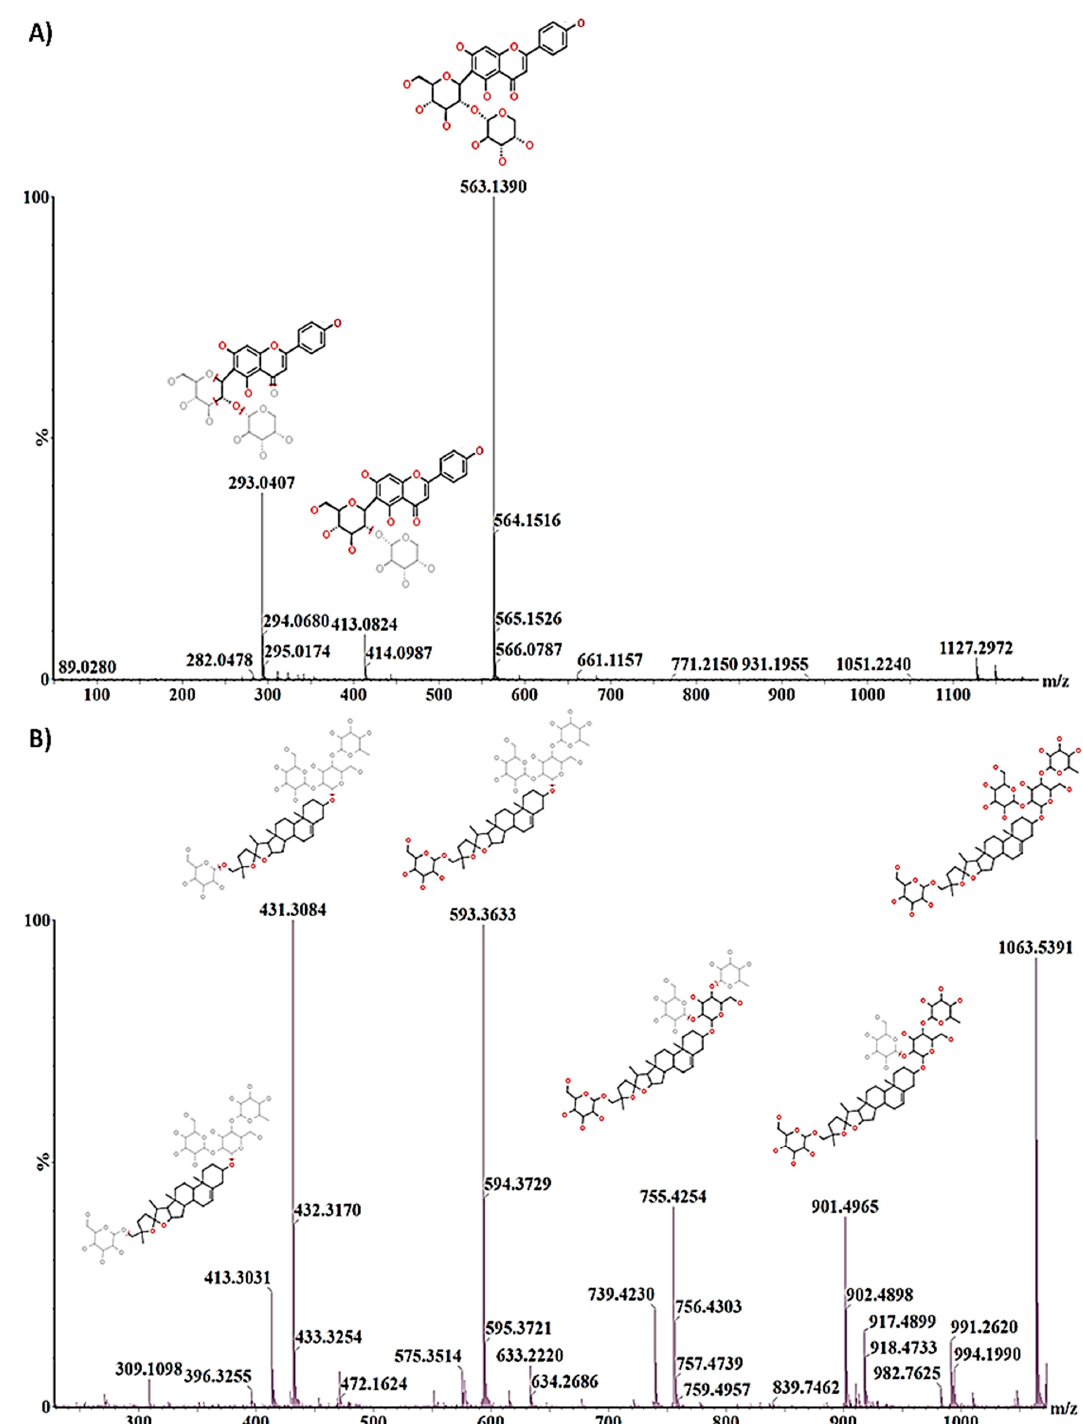
Figure 5. Representation of the use of fragmentation patterns for the annotation of secondary metabolites. ( A ) Isovitexin 2 ″ - O -arabinoside showing the parent ion at m / z 563 and two diagnostic fragment ions at m / z 413 and 293. ( B ) Avenacoside A at an m/z of 1063 showing diagnostic fragments ( m / z 901, 755, 593, 431 and 413) with their structural changes that aid in the structural identification of the metabolite. The fragmentation spectra enable confirmation of the elemental composition and provide useful hints to elucidate possible structural information by evaluating fragmentation patterns yielded at different collision energies, MS E .